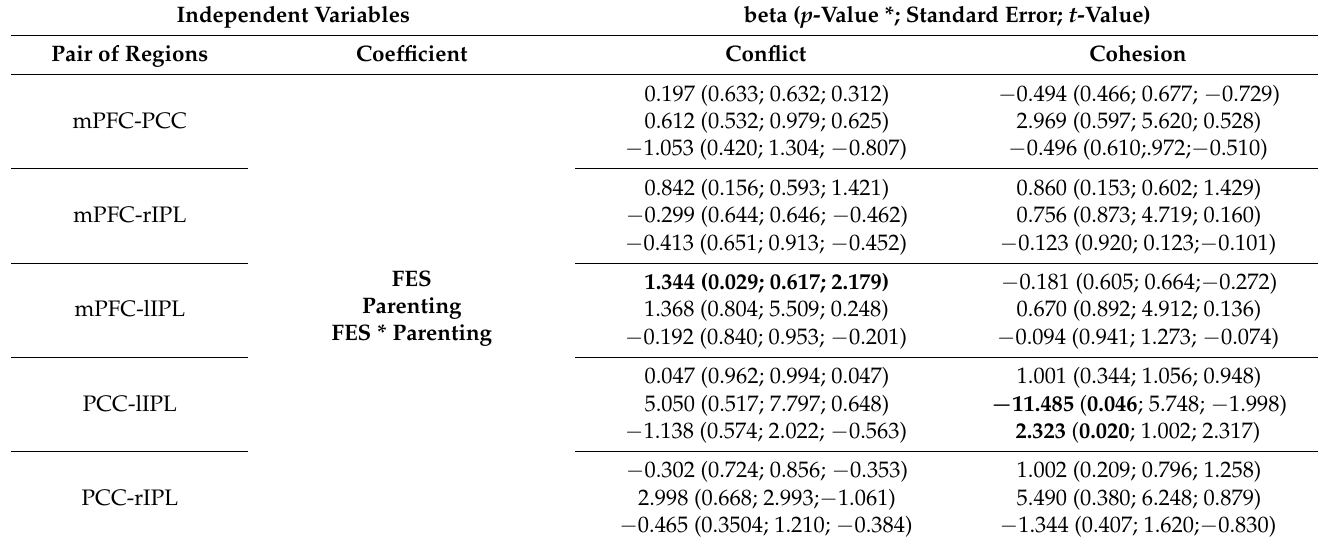
Table 2. GLM coefficients for each DMN link, interpersonal family function (FES) and maternal